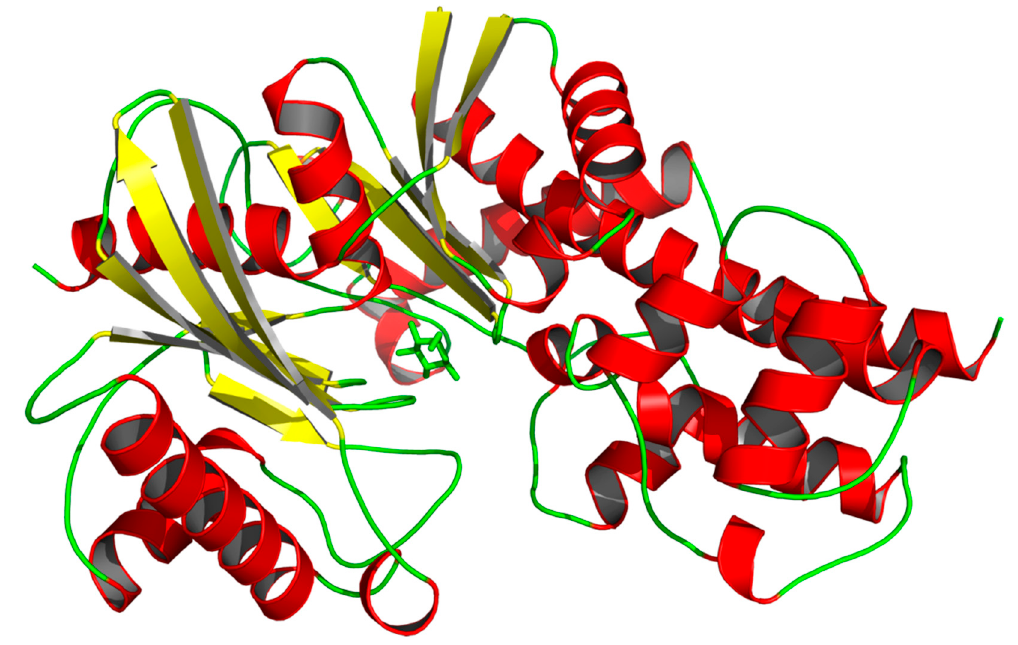
Figure 4. Three-dimensional structure of CmHK. Predictions for CmHK from C. medinalis were generated by SWISS-MODEL and visualized with PyMOL 2.3.4 [66]. Red represents α -helices, yellow indicates β -pleated sheets, and green denotes random coils.